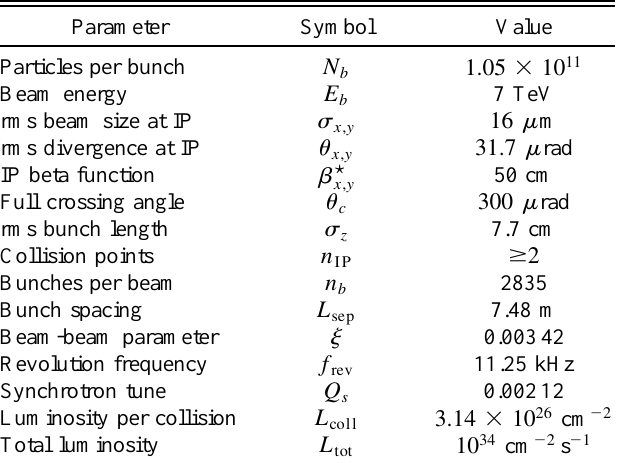
TABLE I. LHC collision parameters